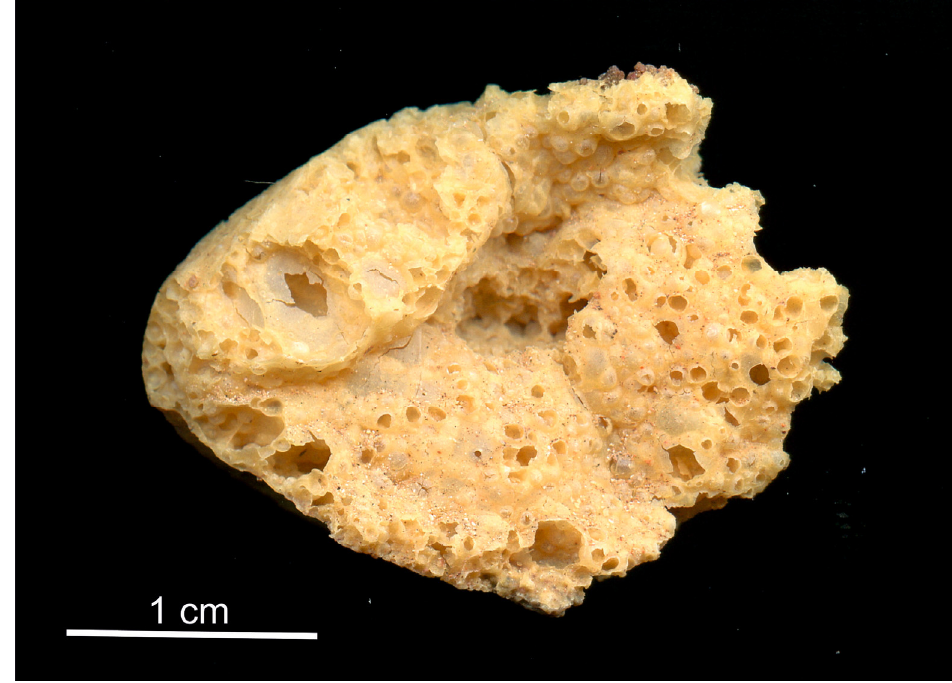
Figure 6. Vesicular mass of almost pure, XRD-amorphous MgSO 4 from